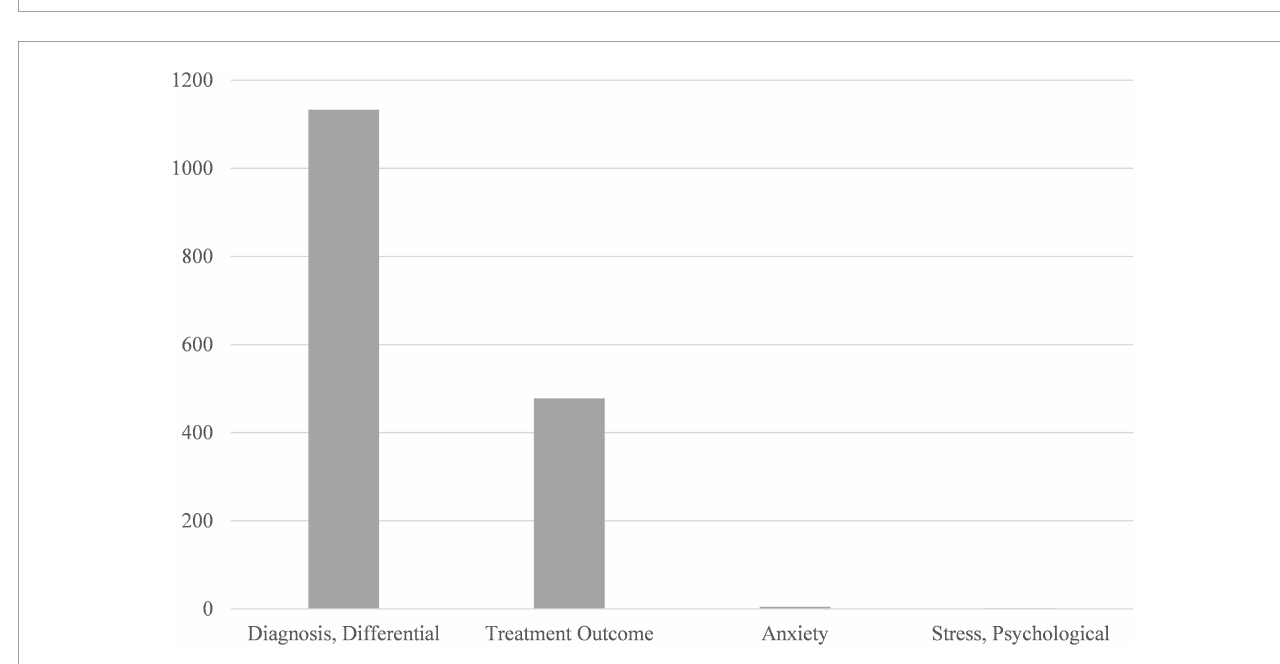
FIGURE5 Comparison between the total amount of Differential Diagnosis, Treatment Outcome, Anxiety, and Psychological Stress.